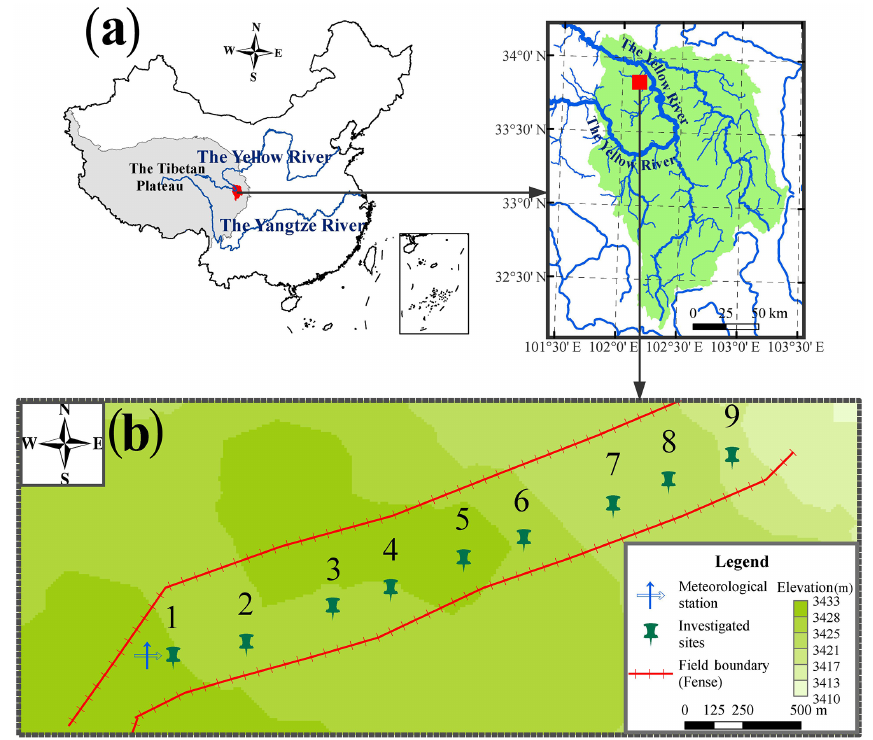
Figure 1. Location of the study area and investigated sites: (a) location of the experimental field in the Zoigê wetland in the east of the Tibetan Plateau, China; (b) distribution of investigated sites within the experimental